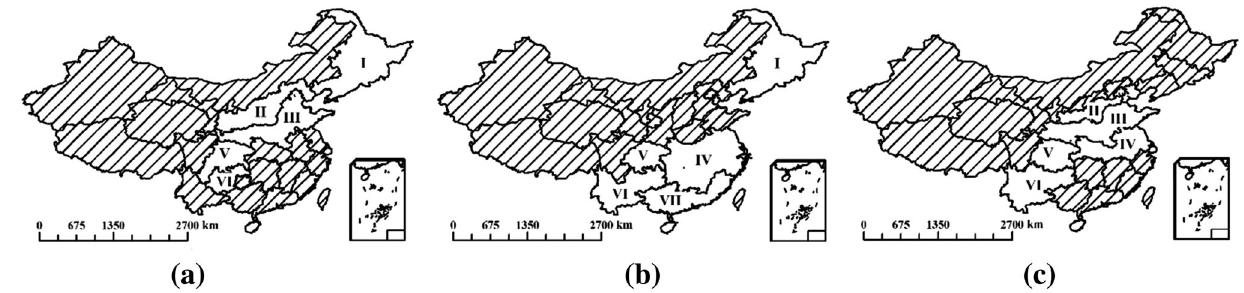
Fig. 1 Agricultural zoning maps of China. a Maize, b Rice,